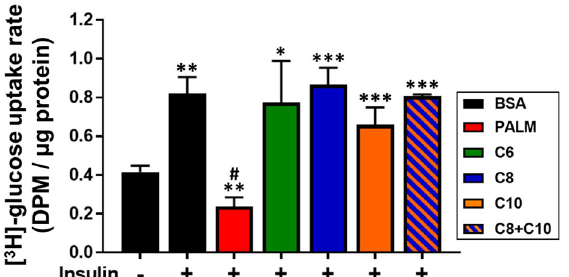
Figure 5. Effect of fatty acids on insulin‐induced glucose uptake by HepG2 cells. HepG2 cells were treated 24 h with 0.25 mM PALM, C6, C8, C10, a C8 + C10 equimolar mix, or vehicle control (BSA). ( 3 H)‐deoxy‐ D ‐glucose uptake assay results ( n = 3) were obtained after a 1 h‐long stimulation with 100 nM insulin (+). * p ‐value < 0.05, ** p ‐value < 0.01, *** p ‐value < 0.001 versus non‐stimulated BSA control. # p ‐value < 0.05 versus stimulated BSA control.